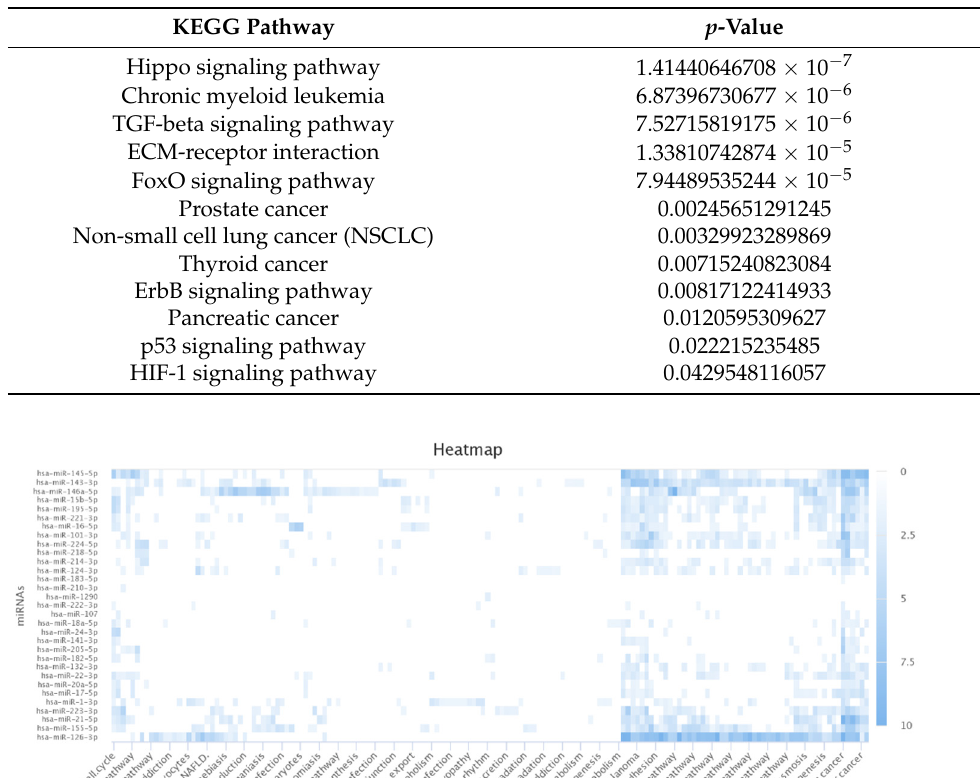
Table 7. The effects of disease constraint on the performance of MDMF.